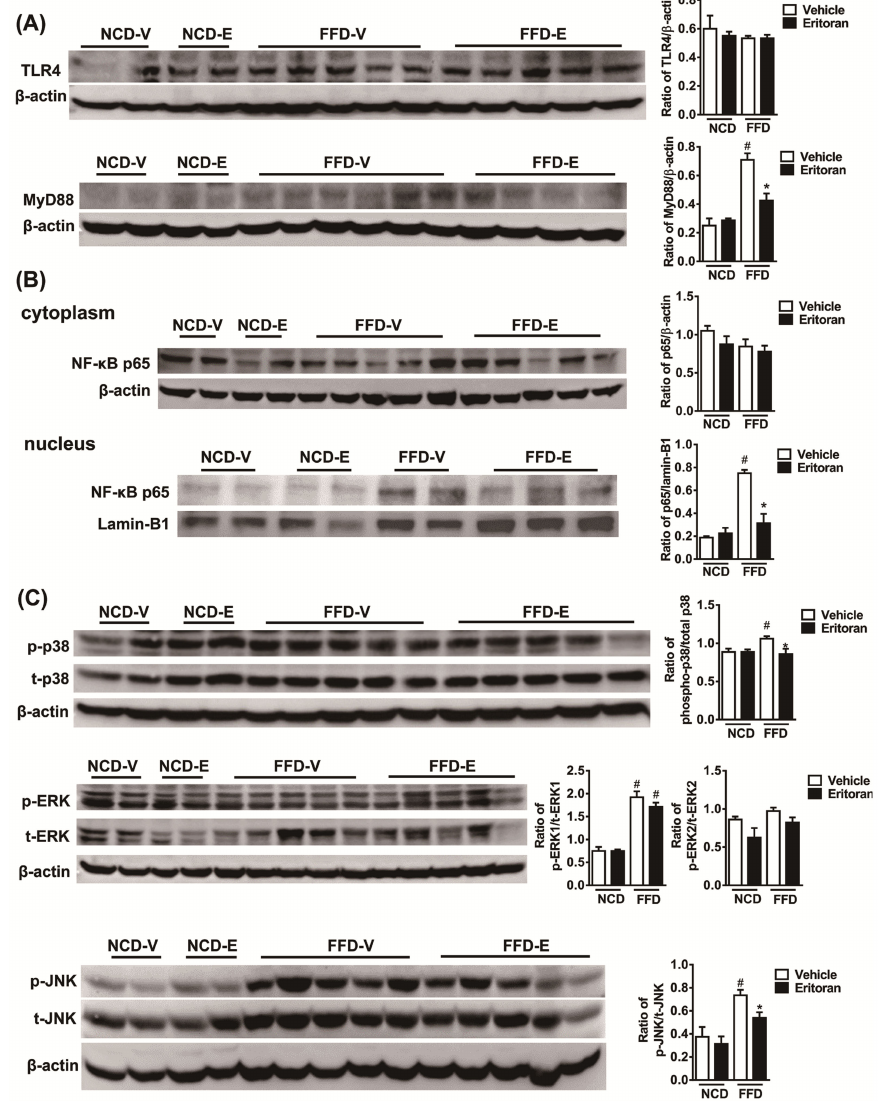
Figure 5. Eritoran suppressed the hepatic TLR4 downstream signaling pathway in the mice fed a fast-food diet. Western blot analysis and quantification of ( A ) TLR4 and myeloid differentiation factor 88 (MyD88); ( B ) cytoplasmic and nuclear NF- κ B p65; ( C ) phosphorylated and total p38 (p/t-p38), extracellular signal- regulated kinase 1 and 2 (p/t-ERK1/2) and c-Jun N-terminal kinase (p/t-JNK) expression in the livers. NCD-V/NCD-E: the mice fed a normal chow diet (NCD) were injected with a vehicle (NCD-V, n = 6) or eritoran (NCD-E, n = 6); FFD-V/FFD-E: the mice fed a fast-food diet (FFD) were injected with a